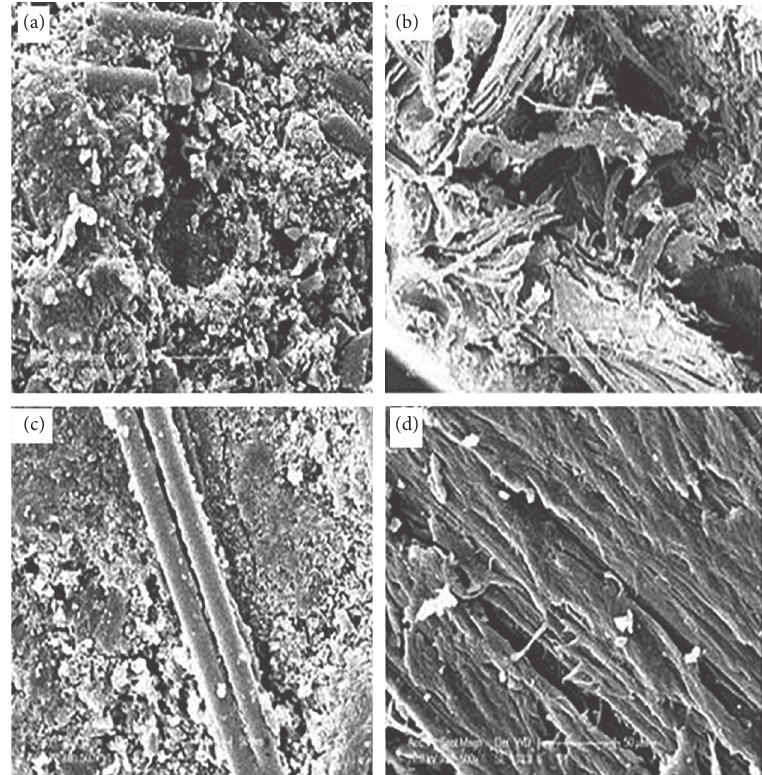
Figure 2: SEM images. (a) Untreated Prosopis juliflora fiber. (b) 15% NaOH-treated fiber. (c) 10% NaOH-treated fiber. (d) 5% NaOH- treated fiber